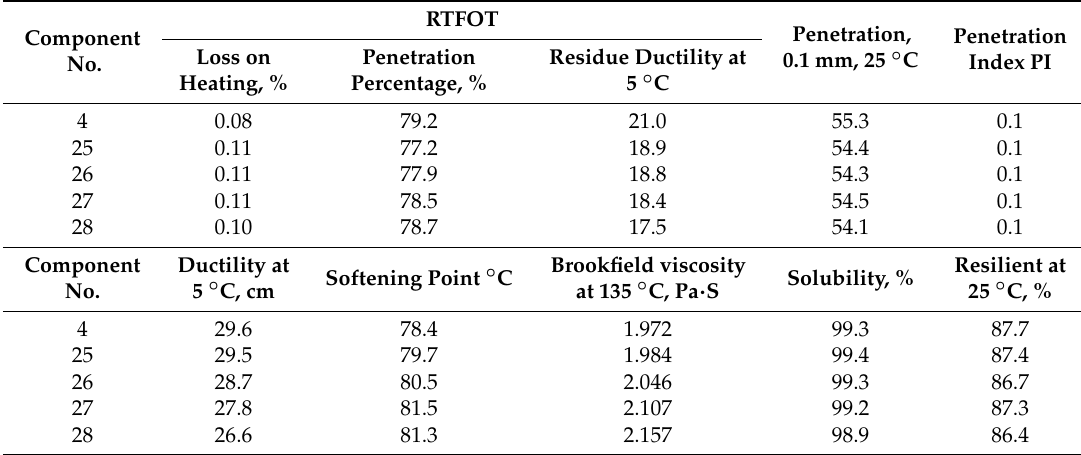
Table 7. Performance of SBS-modified bitumen with different kaolin content.